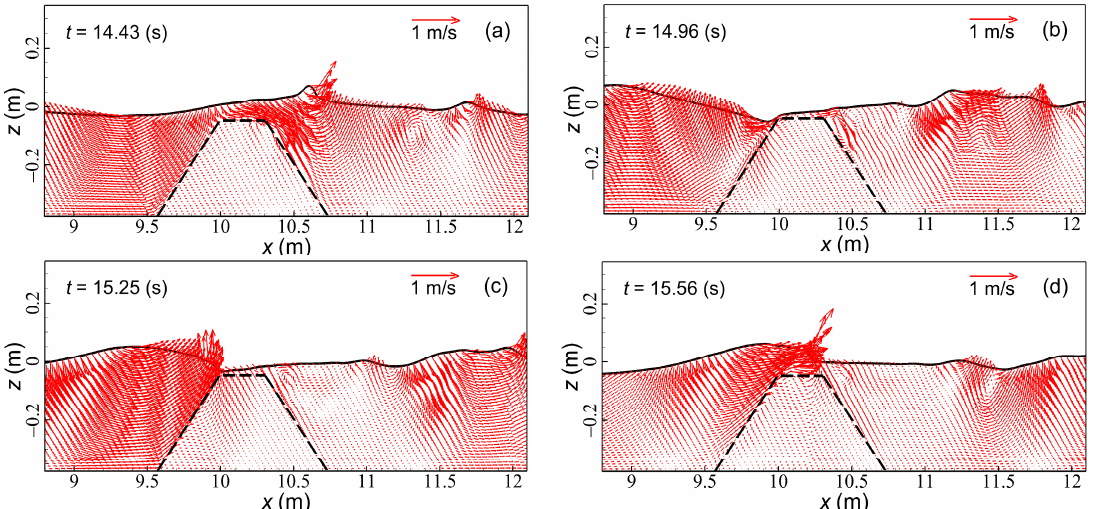
Figure 5. Distribution of the vector velocity field at different times; dash line: submerged permeable breakwater; ( a ) 𝑡 = 14.43 s; ( b ) 𝑡 = 14.96 s; ( c ) 𝑡 = 15.25 s; ( d ) 𝑡 = 15.56 s.